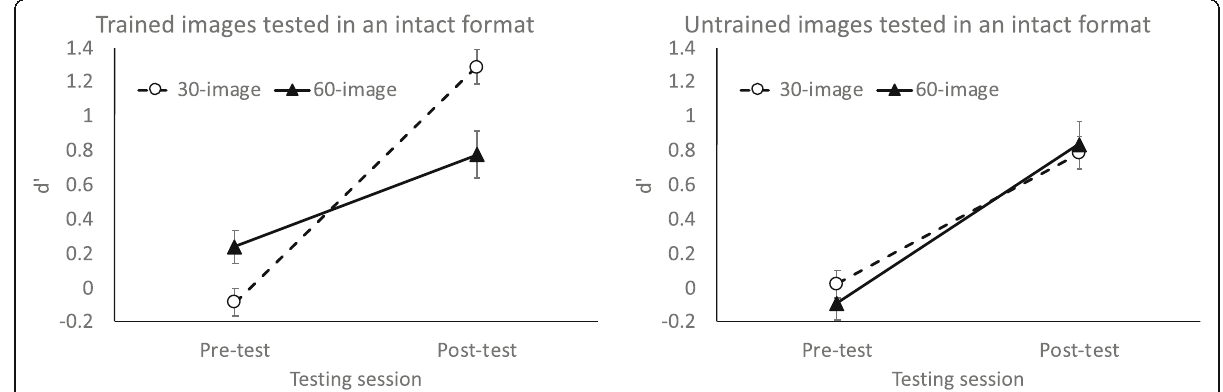
Fig. 5 Value of d ’ across pre-test and the final post-test, when tested with intact trained images (left) and intact untrained images (right). Error bars show +/ − 1 S.E. of the